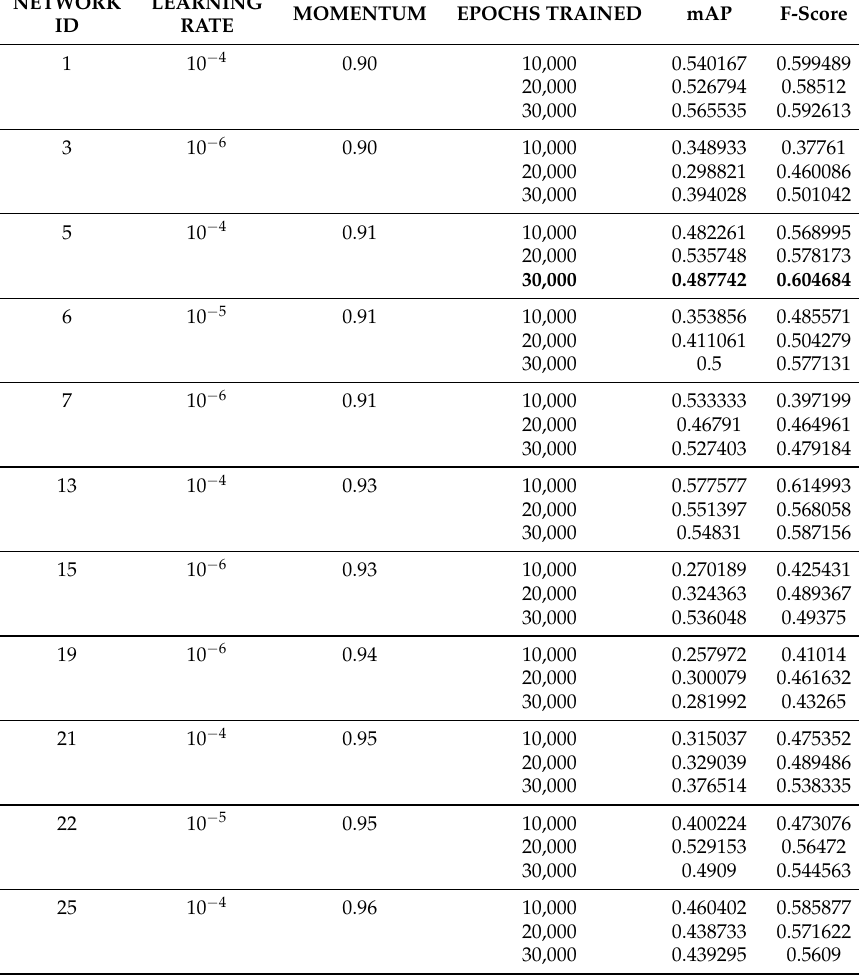
Table 6. Preliminary Rank-5 results obtained for mean Average Precision (mAP) and F-score by modifying the values for learning rate and momentum. All of these tests were implemented on PRW-v16.04.20